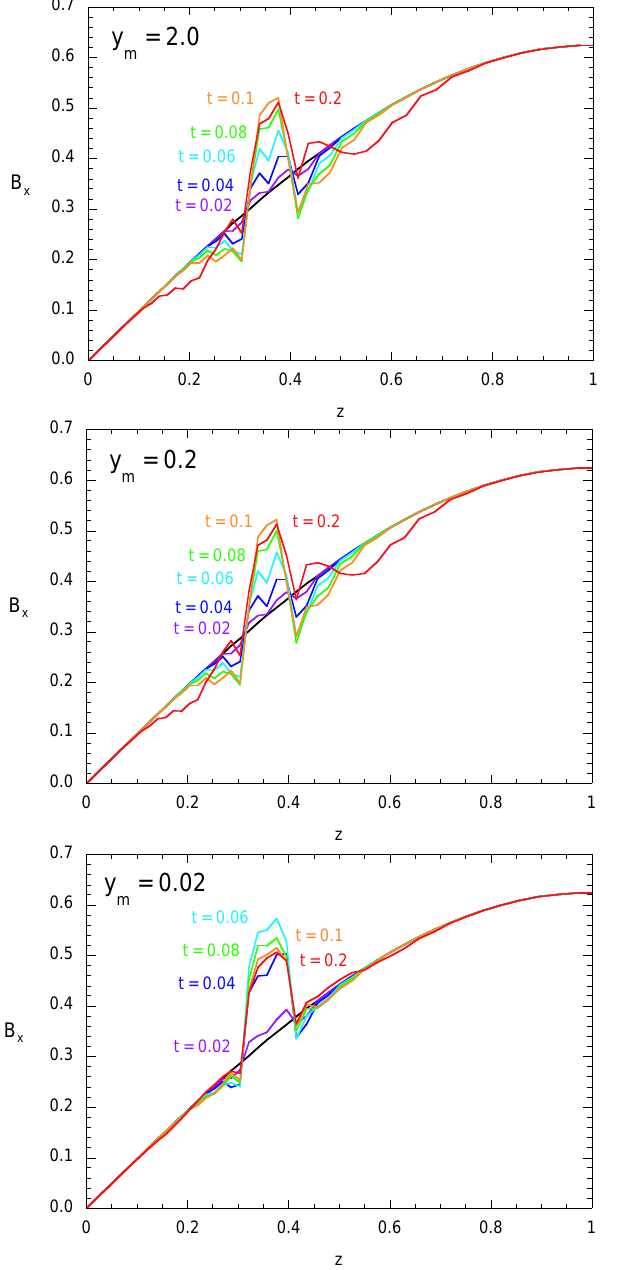
Fig. 4. Magnetic field B x at x =− 5 . 7 ,y = 0 as a function of z at different times and for 3 different bubble widths, as indicated.